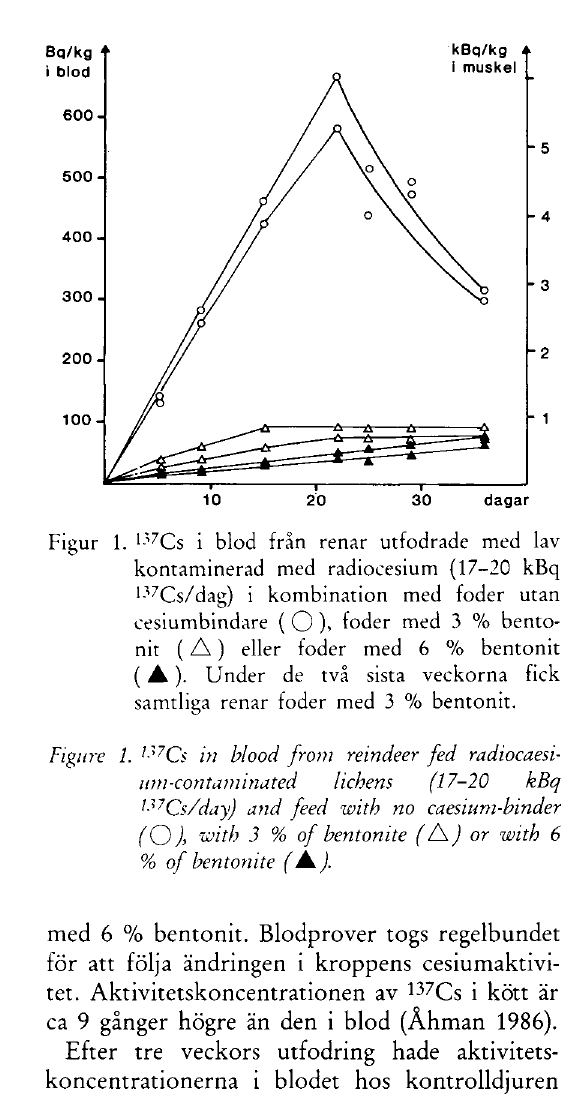
Figur 1. 137 Cs i blod från renar utfodrade med lav kontaminerad med radiocesium (17-20 kBq 137 Cs/dag) i kombination med foder utan cesiumbindare ( O ), foder med 3 % bento-